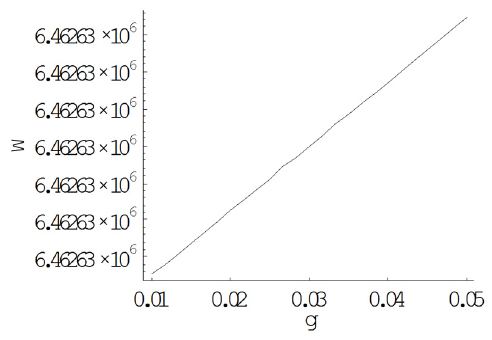
Figure 14. Total cost versus parameter g